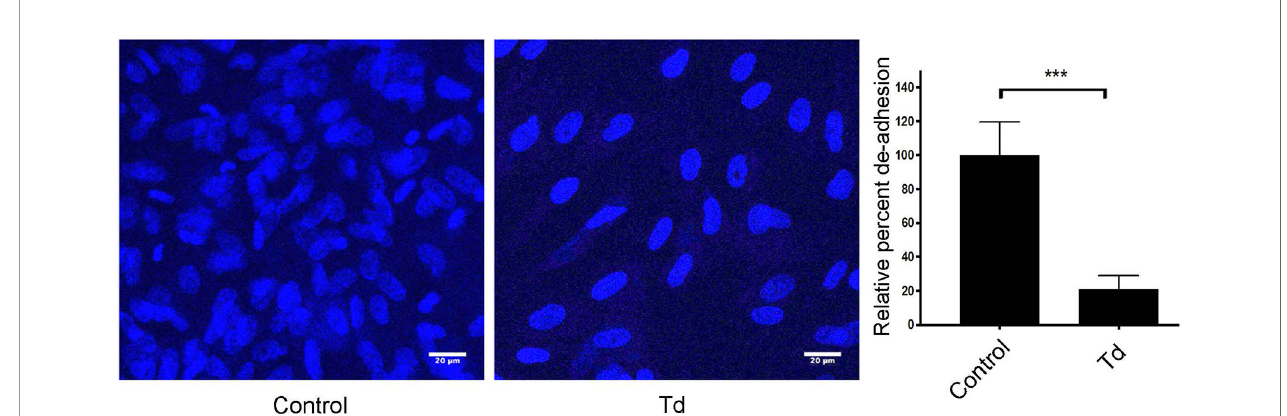
FIGURE 1 | PDL cell attachment and contractility is impaired by T. denticola challenge. PDL cells were unchallenged (control) or challenged with T. denticola (50 MOI) for 24 h and processed for immuno fl uorescent staining with Hoechst (nucleus, blue), and imaged with Confocal Microscopy. Representative phase contrast images are shown, and graphs show the percent change in de-adhesion after 24 h. Data represent mean ± SD from three independent experiments. Data were compared using Student ’ s t-test. *** =